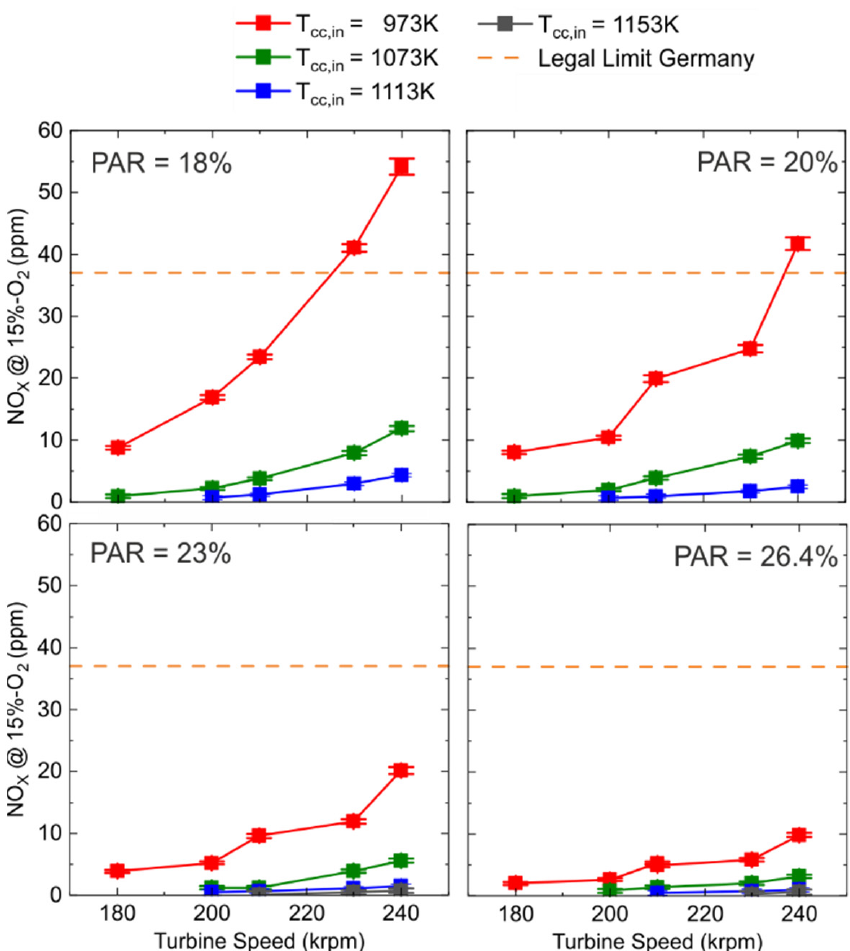
Figure 8. NO X emissions as a function of turbine speed for different combustor inlet temperatures T cc,in .